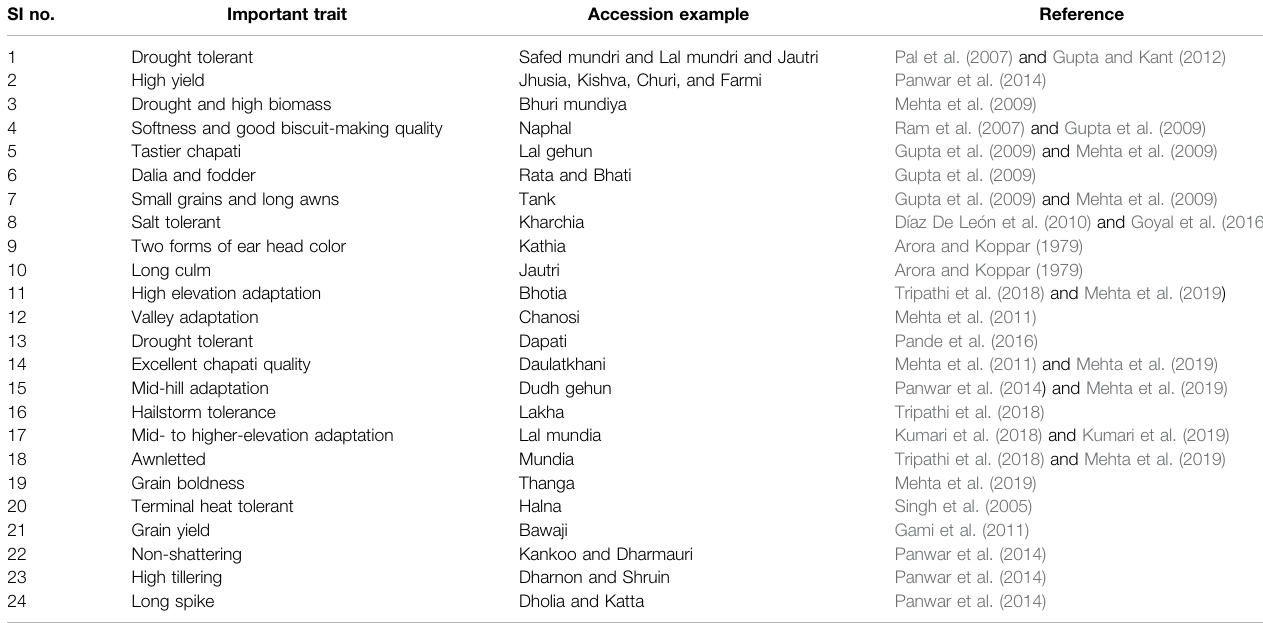
TABLE 1 | Perceptual dissemination of trait-speci fi c Indian wheat germplasm collection. SI